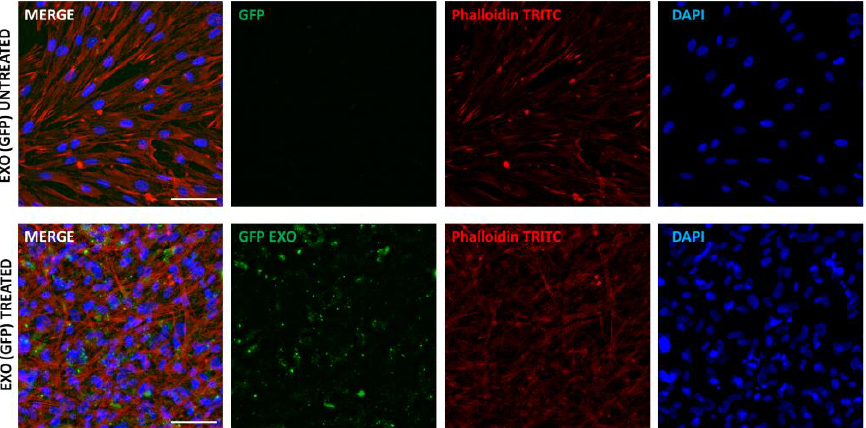
Figure 4. CAFs from cutaneous basal cell carcinoma were treated by commercially available GFP- tagged exosomes for 12 h. Cells were consequently fixed by paraformaldehyde, permeabilised, and counterstained using phalloidin-TRITC (to show actin in the cytoplasm) and DAPI (to show DNA in the nuclei). Imaging was performed with a Leica Thunder Imager using the computational clear- ing technique to efficiently differentiate between the signal and background to visualise the distri- bution of GFP-tagged exosomes in CAFs. Bar represents 100 μm. of GFP-tagged exosomes in CAFs. Bar represents 100 µ